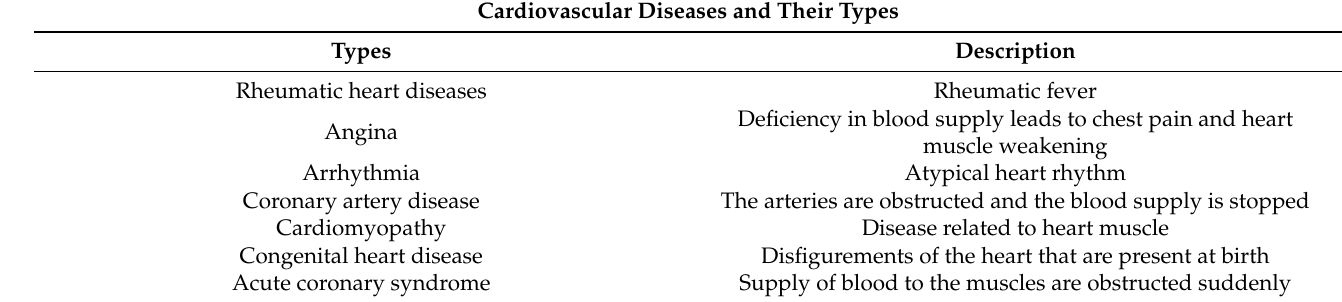
Table 1. Cardiovascular diseases: an overview. Cardiovascular Diseases and Their